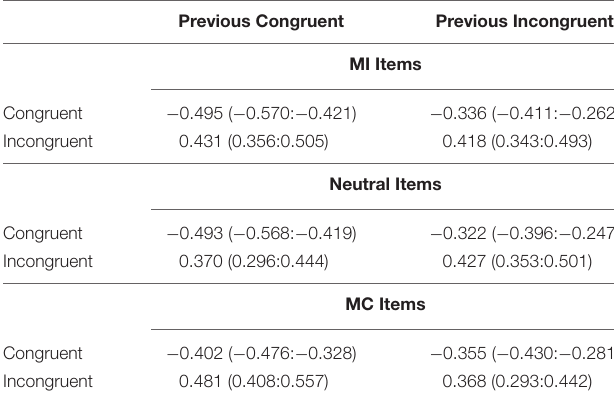
TABLE 3 | Mean z -scored RTs (and HDIs) for each condition in the CSE analysis of Experiment 2. Previous